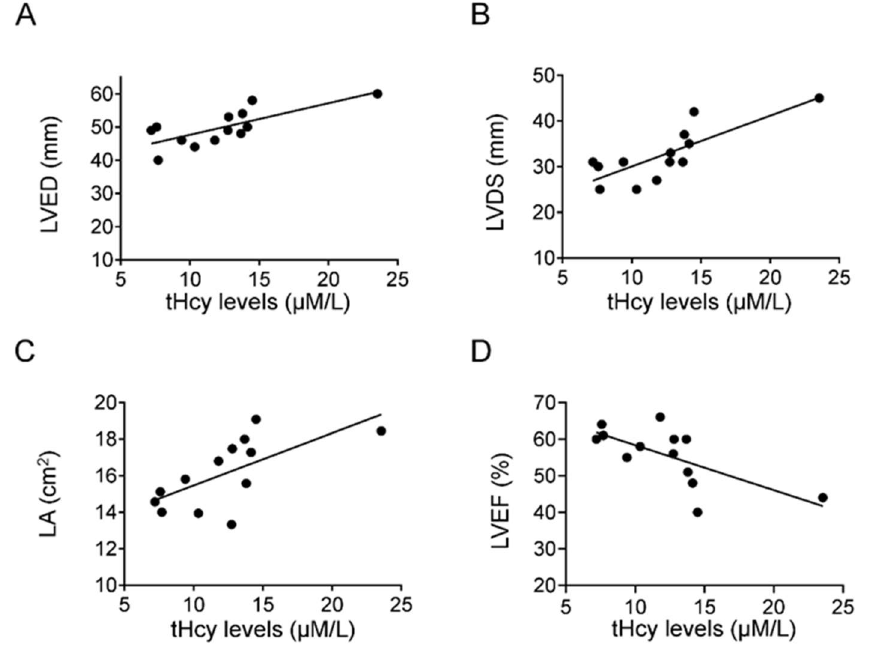
Figure 3. Data show that echocardiographic parameters of the heart correlate with homocysteine levels of patients undergoing CABG surgery. Pearson’s correlation analysis showed positive correlations between tHcy levels vs. LVED (y = 0.8499x + 38.76; r = 0.6; p < 0.01), LVDS (y = 0.9713x + 19.82; r = 0.7; p < 0.01), LA (y = 0.2956x + 12.54, r = 0.7, p < 0.01; A – C ), and an inverse correlation between tHcy levels vs. LVEF (y = −1.0154x + 69.299; r = 0.5; p < 0.05) ( D ). CABG—coronary artery bypass graft surgery; LVED—left ventricular end-diastolic diameter; LVDS—left ventricular end-systolic diameter; LA—area of the left atrium; LVEF—left-ventricular ejection fraction; tHcy—total homocysteine; p < 0.05 was considered significant.